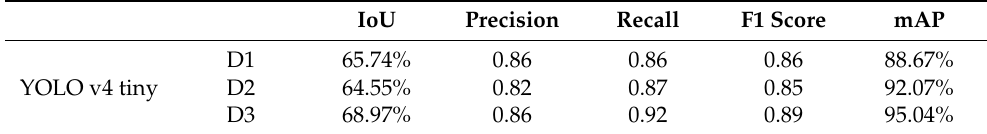
Table 4. K-fold performance evaluation parameters.